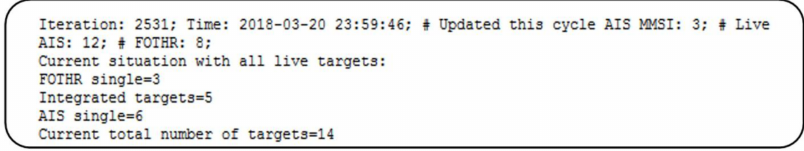
Figure 10. One iteration log